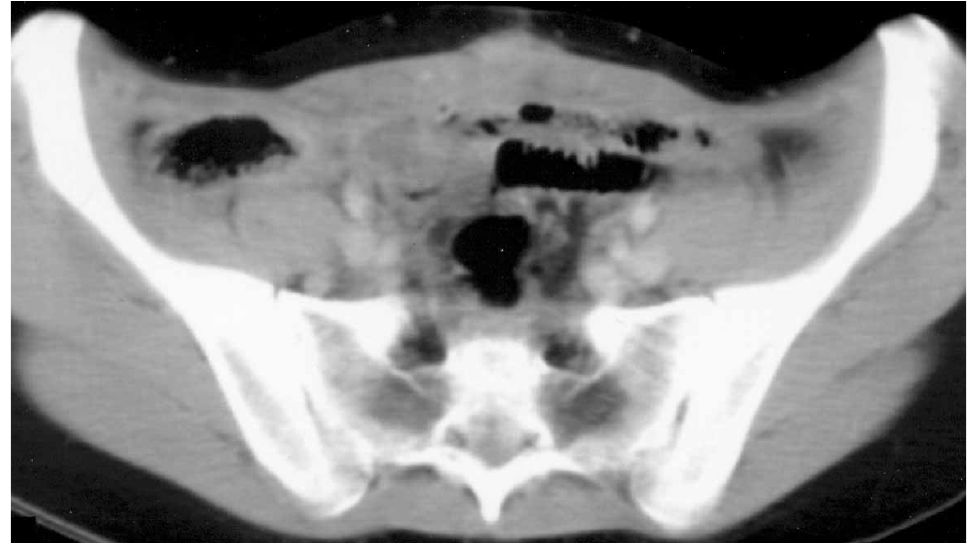
Fig. 6. CT taken in February 2003 showing resolution of the dense abdominal fibromatosis. There are visible normal gas-filled loops of bowel as the GI tract is no longer